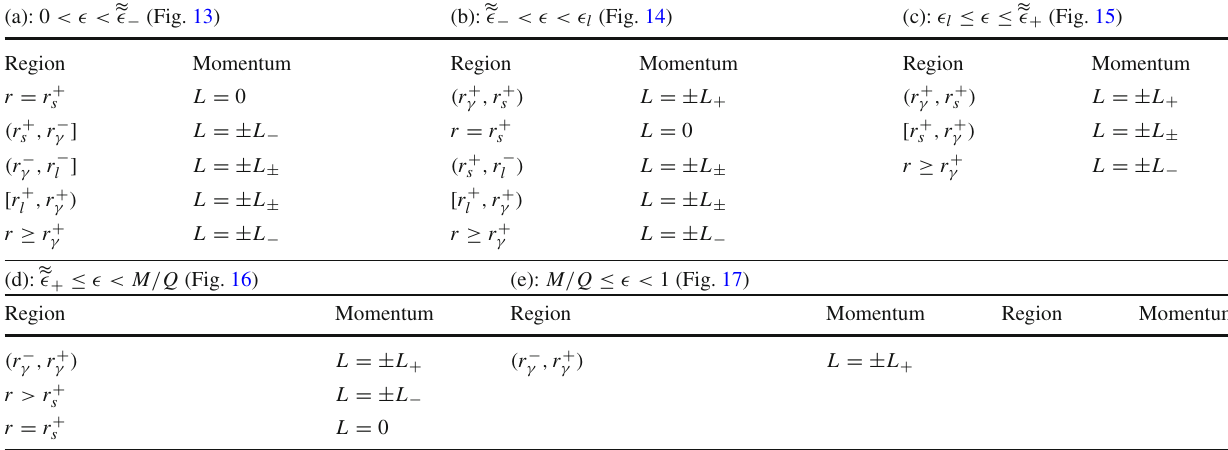
√ √ 6 ) M < Q < ( 3 6 / 7 ) M , for a test particle charge-to-mass ratio (cid:2) ∈] 0 , 1